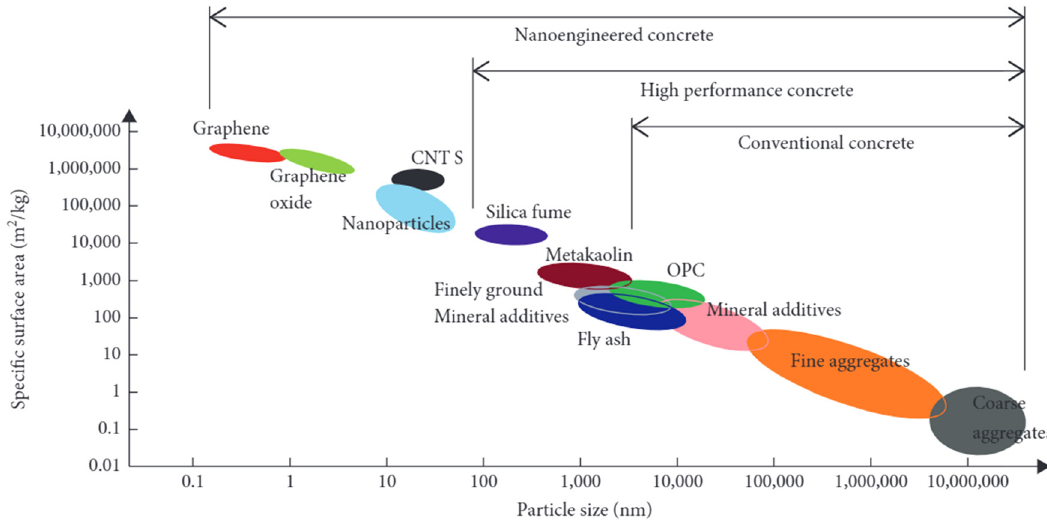
Figure 1: Relationship between particle size and speci fi c surface area of concrete [ 15 ]